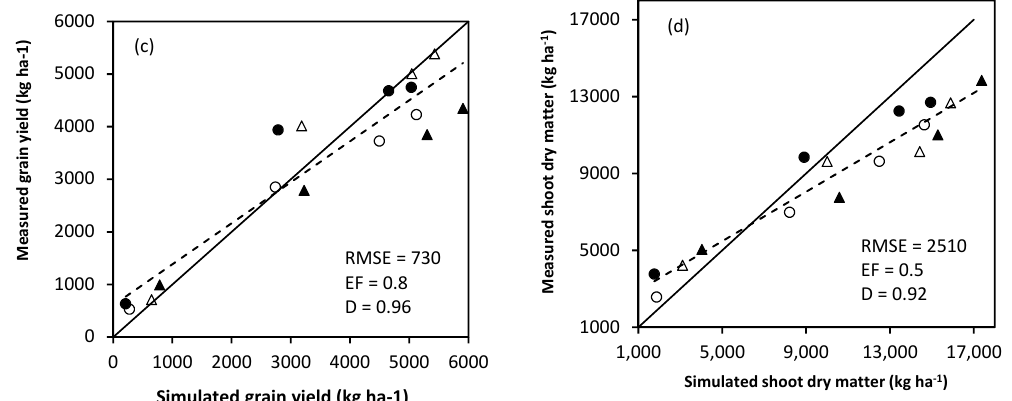
Figure 5. Comparison of simulated and measured anthesis ( a ), physiological maturity ( b ), grain yield at maturity ( c ) and shoot dry matter at maturity ( d ) for SAMMAZ-16 using Iburu and Zaria experimental data sets. (Iburu = ▲ 2015, ○ 2016 and Zaria = ● 2015, Δ 2016, the plants were grown under four N treatments within each location and date).